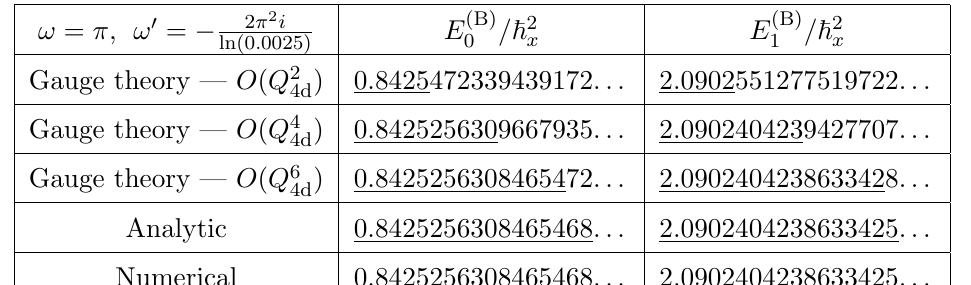
Table 2 . Energies for the 2-eCM B model at g x = 3